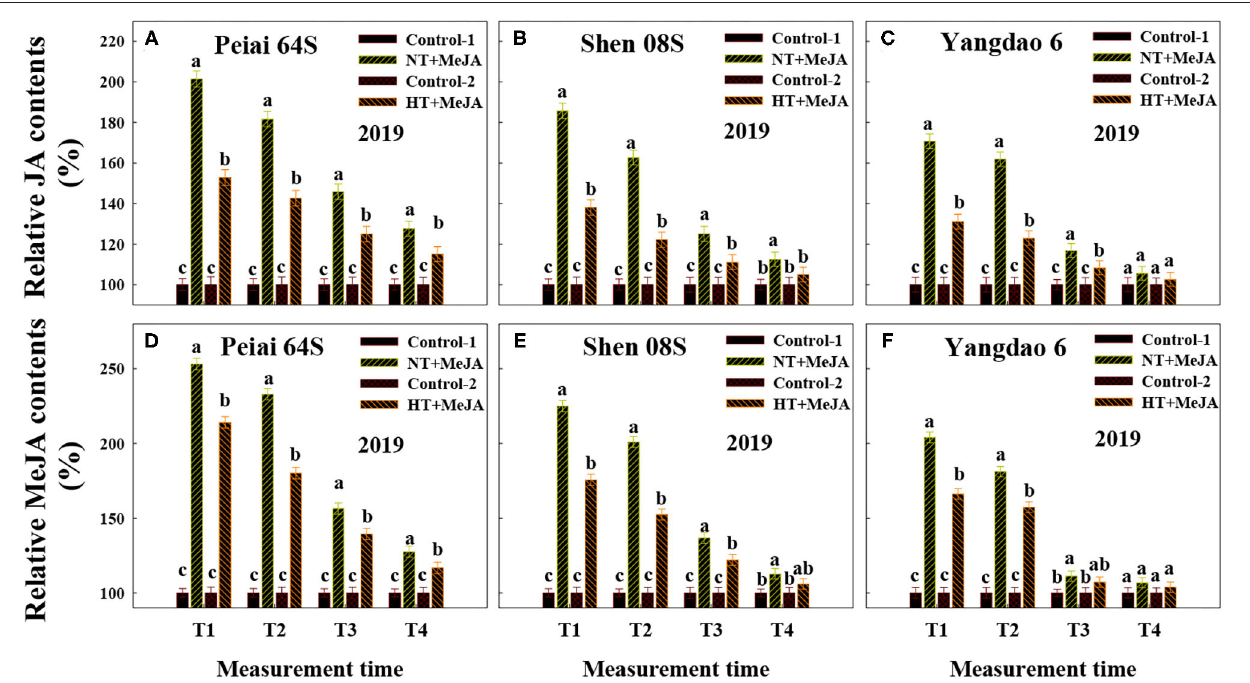
FIGURE 3 | Effect of MeJA application on the contents of JA (A–C) and MeJA (D–F) in stigmas of rice subjected to high-temperature stress during anthesis. Control-1 and Control-2 indicate spraying water under normal temperature (NT) and spraying water under high temperature (HT), respectively. NT + MeJA and HT + MeJA represent spraying MeJA under NT and spraying MeJA under HT, respectively. Data are expressed as relative values, and those of controls are taken as 100%. T1: 12:00h on the first day during the temperature treatment; T2: 14:00h on the first day during the temperature treatment; T3: 14:00h on the second day during the temperature treatment; T4: 14:00h on the first day after the temperature treatment. The bars are SD of three biological replications. Different letters above the bars represent significant differences at the P ≤ 0.05 level within the same line and the same measurement time.